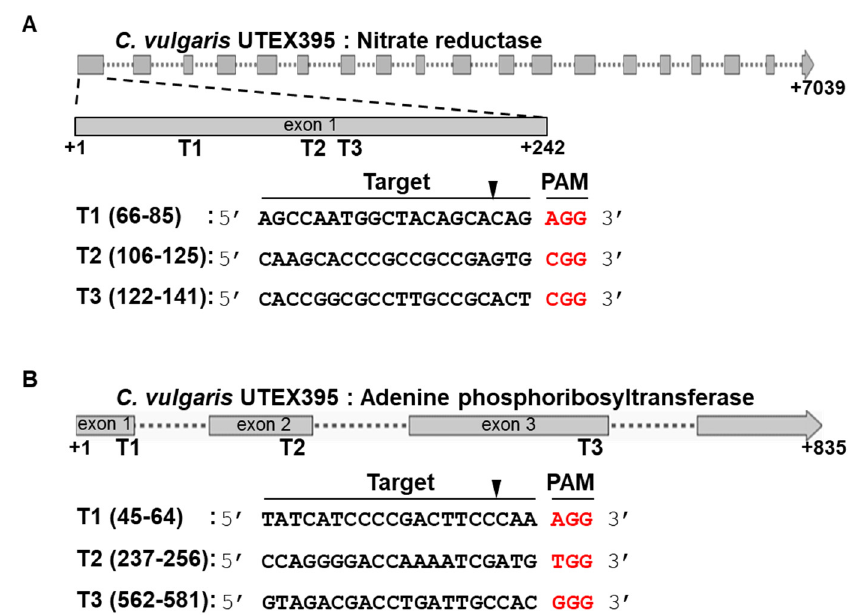
Figure 1. Design of the single guide RNA (sgRNA) sequences for genome editing of ( A ) NR and ( B ) APT . Twenty bp-long target sequences (black) and 3 bp-long PAM sequences (red) are presented below the illustration of the gene. Triangles indicate the cleavage sites.